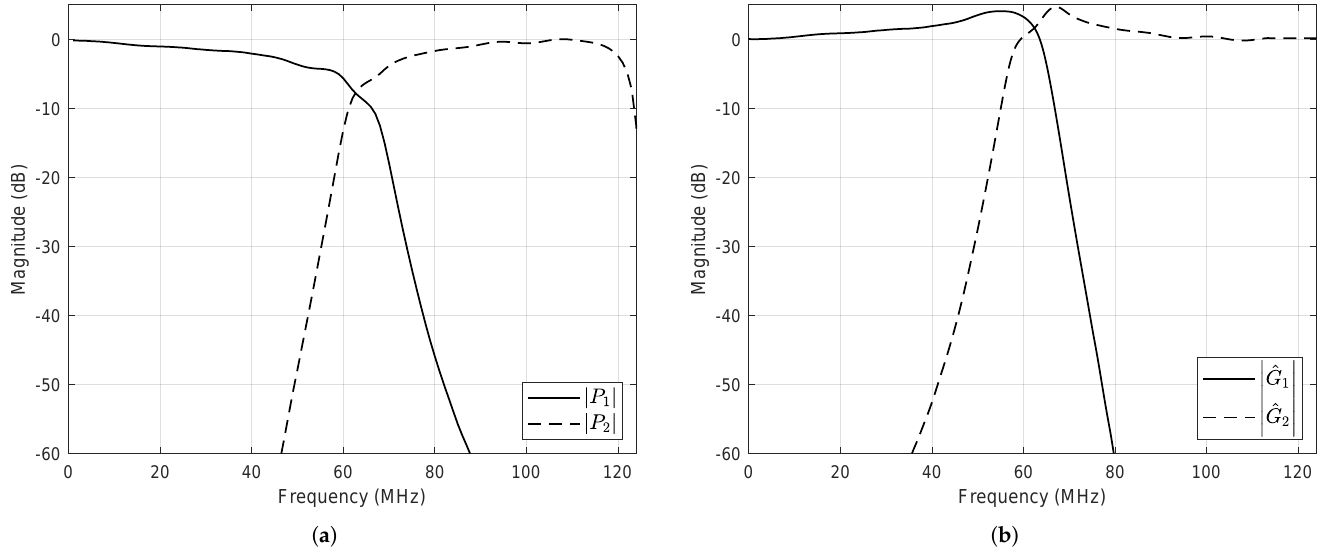
Figure 13. Frequency response of the analysis and reconstruction filters in the synchronous mixing DBI system: ( a ) analysis filter bank; ( b ) reconstruction filter